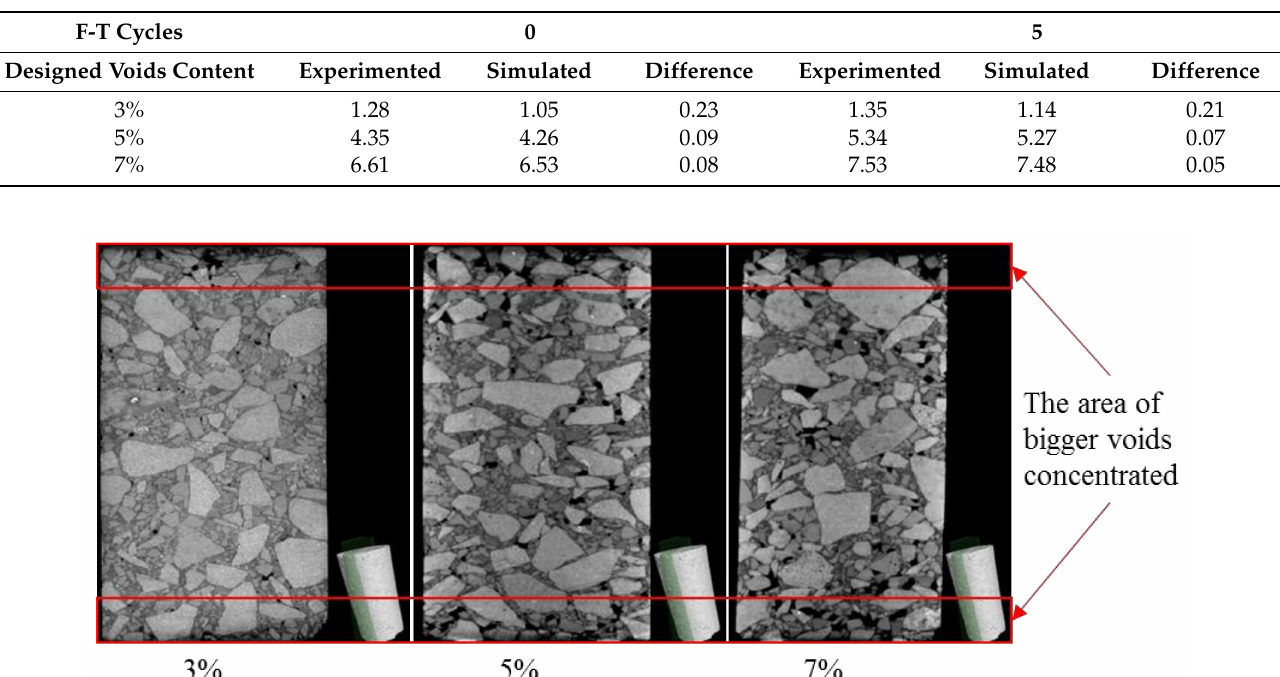
Table 4. Laboratory experimented and simulated variables with six combinations.